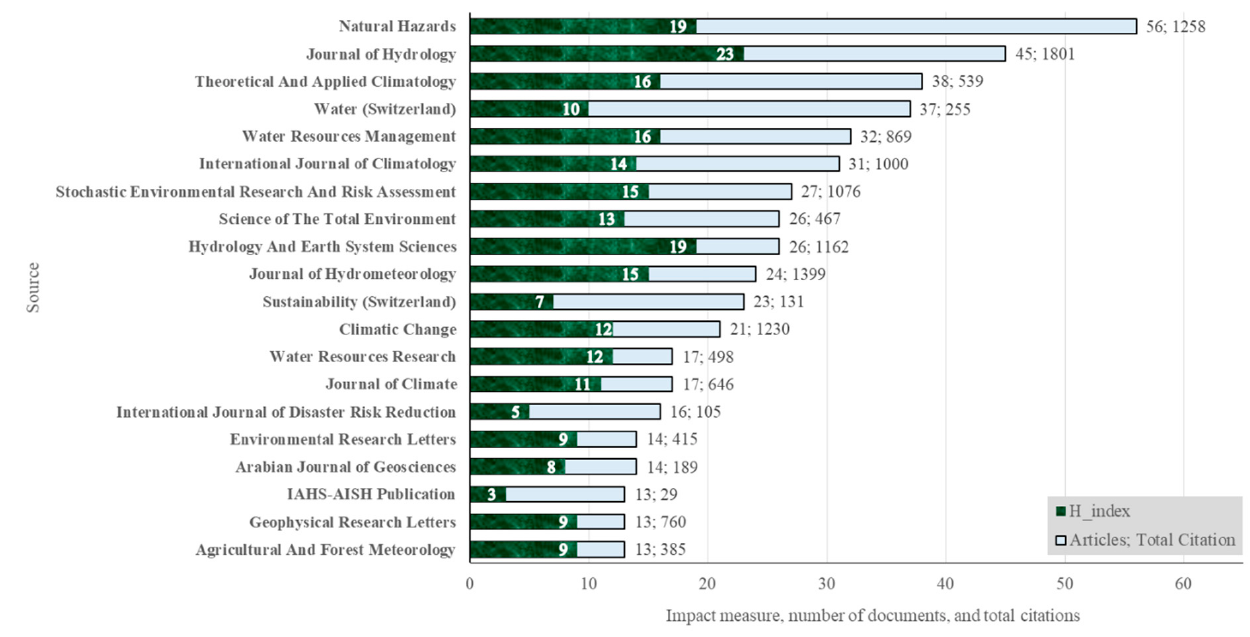
Figure 14. Most relevant sources in the DR_DF field.